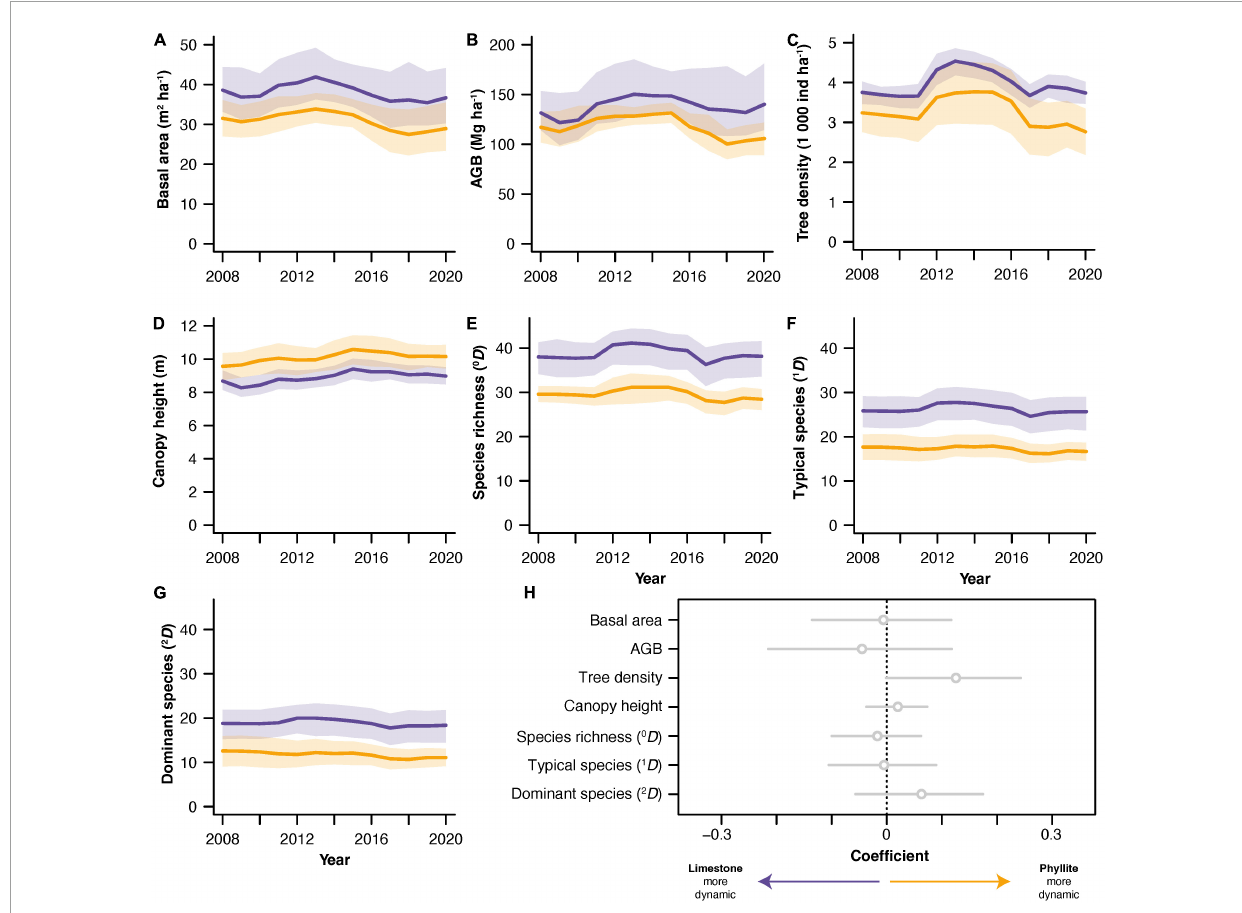
FIGURE2 Dynamics of tropical dry forest attributes in limestone (purple) and siliciclastic phyllite (yellow) substrates. Panels show the dynamics of (A) basal area, (B) aboveground biomass (AGB), (C) tree density, (D) canopy height, (E) species richness ( 0 D ), (F) number of common species ( 1 D ), (G) number of dominant species ( 2 D ), and (H) the substrate-wise comparison of the dynamics of all seven TDF attributes analyzed. For panels (A–G) , the thick lines represent substrate mean values ( n = 7) and the shading around them represents 95 % confidence intervals. For panel (H) , the substrate-wise comparison of dynamics was done by regressing the deviations of each plot from its substrate mean value as a function of forest substrate standardized dynamics shown in Supplementary Figure 1 . Linear mixed-effects models were used to control for temporal autocorrelation due to repeated measurements, including plots as a random effect. Coefficients = 0 represent identical attribute dynamics between the two substrates, coefficients > 0 represent more intense dynamics in phyllite TDF, and coefficients < 0 represent more intense dynamics in limestone TDF. Mean coefficients and their 95 % confidence intervals are shown for each